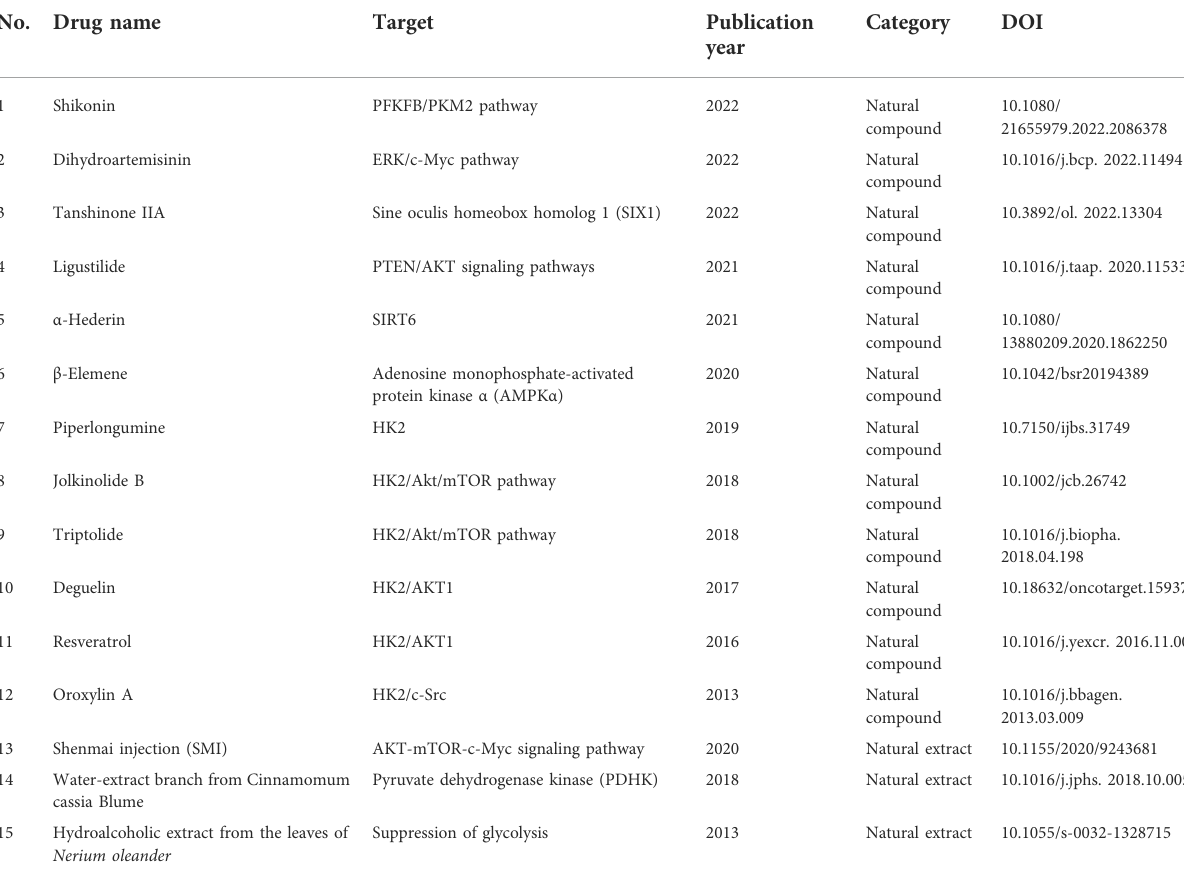
TABLE 4 Natural products targeting glycolysis in